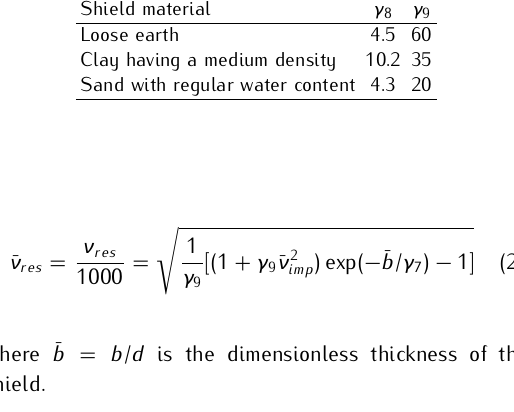
Table 6. Parameter γ